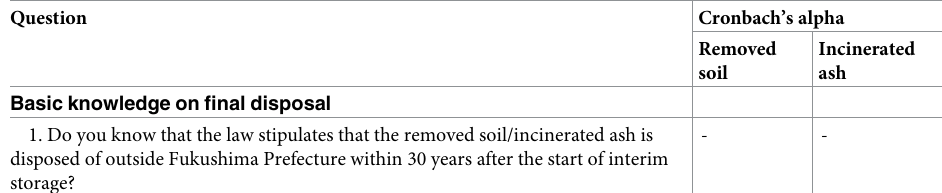
Table 3. Questionnaire items for grouping respondents and the reliability